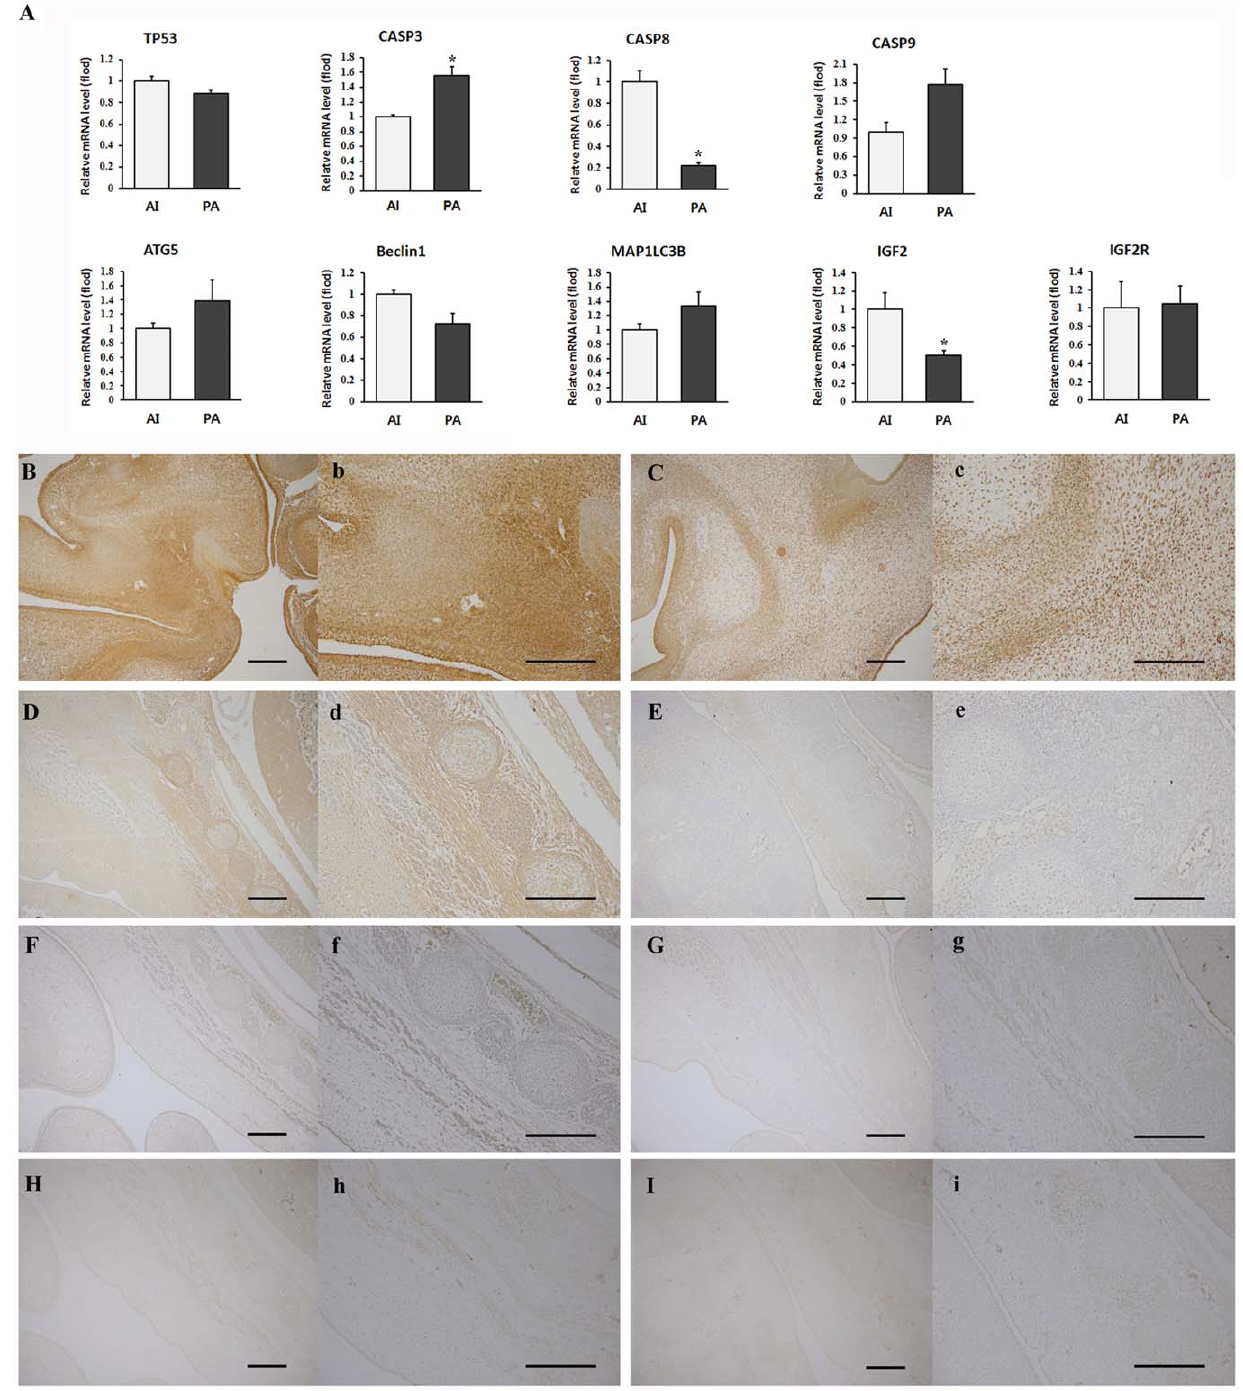
Figure 6. Comparison of expression patterns for apoptosis, autophage and growth related genes in day 30 controls and canine parthenotes. (A) Gene expression levels of apoptosis, autophage and growth related genes. Data presented as mean 6 SEM of at least three replicates. The asterisk denotes a probability value of , 0.05. (B–H, b–h) Immunohistochemical analysis of control (B, D, F, H, b, d, f, h) and canine parthenogenetic fetuses (C, E, G, I, c, e, g, i). Immunohistochemacal staining for CASP8 (B–C, b–c), FADD (D–E, d–e), LC3A/B (F–G, f–g) and ERK1 (H–I, h–i) were performed and canine parthenote exhibited decreased expression of CASP8 and FADD, while no differences in LC3A/B and ERK1 were identified. All scale bars represent 200 m m.